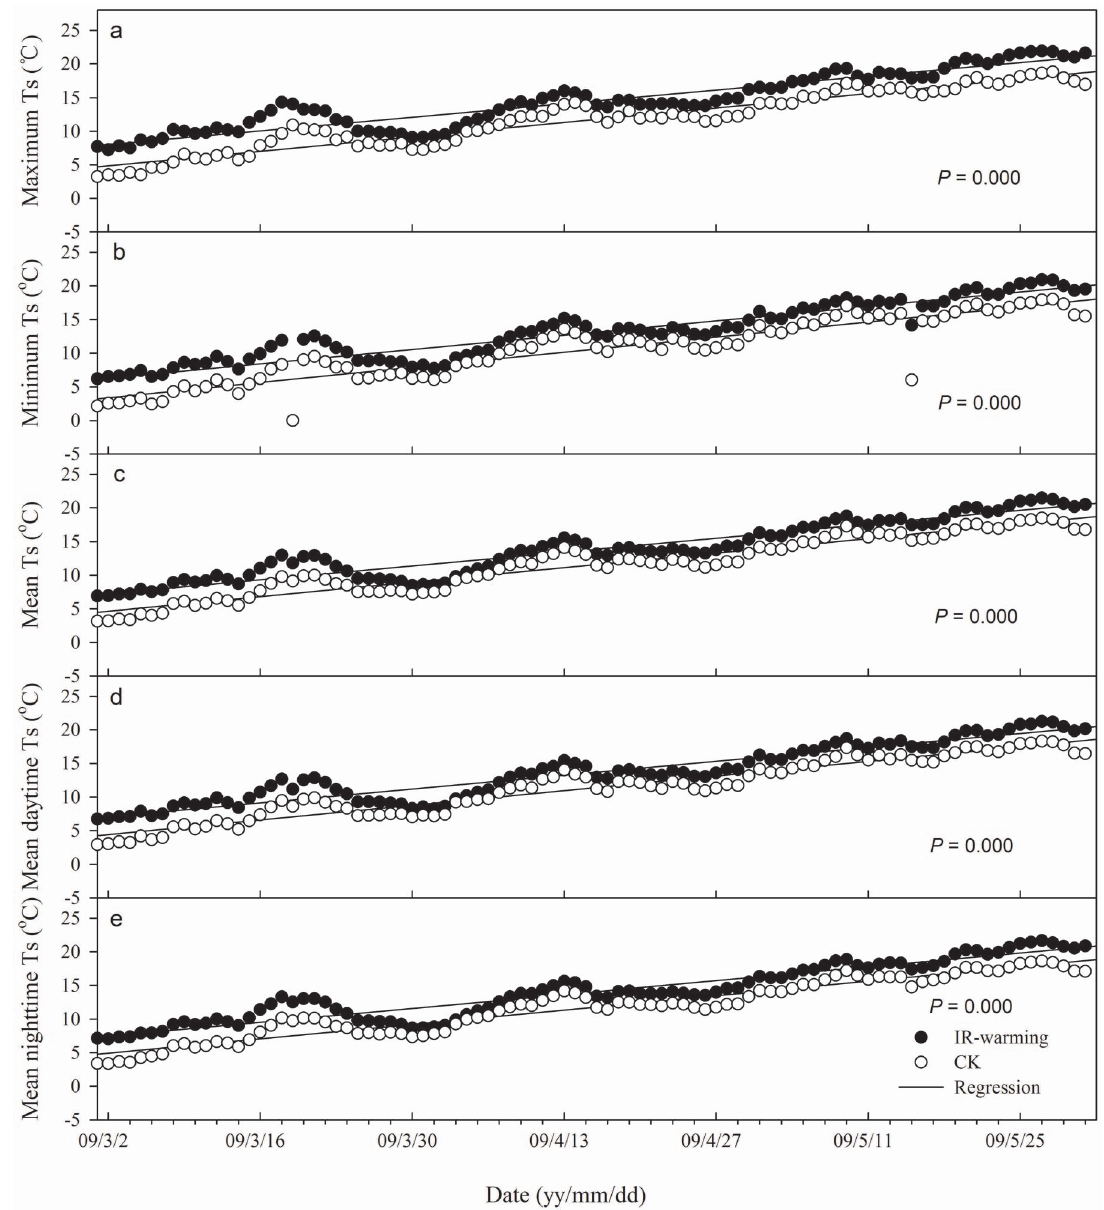
Figure 3. Comparison of soil temperature ( T s ) between IR-warming and control (CK) plots. T s,max , the maximum daily soil temperature; T s,min , the minimum daily soil temperature; T s,avr , the average daily soil temperature; T sd,avr , the average soil temperature during daytime; T sn,avr , the average soil temperature during nighttime; P value are used to show significance. P , 0.05 indicated significant difference between regressions.